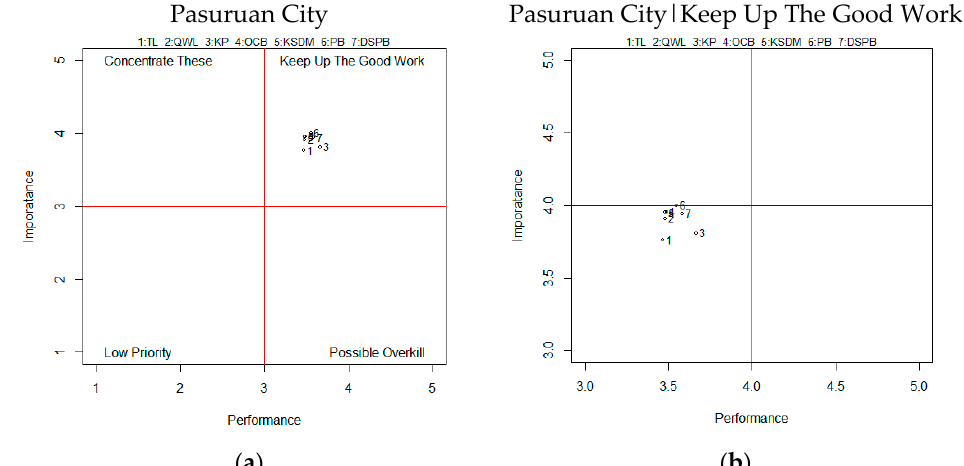
Figure 4. ( a ) IPA Cartesian Diagram of Pasuruan City. ( b ) IPA Cartesian Diagram of Keep up the Good